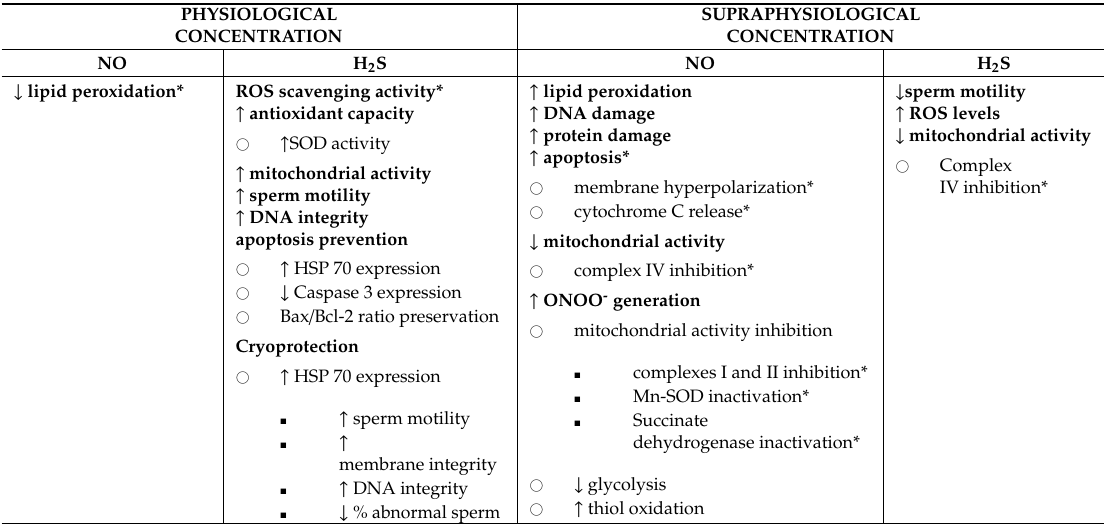
Table 2. The e ff ects of nitric oxide (NO) and hydrogen sulfide (H 2 S) on cellular function. PHYSIOLOGICAL